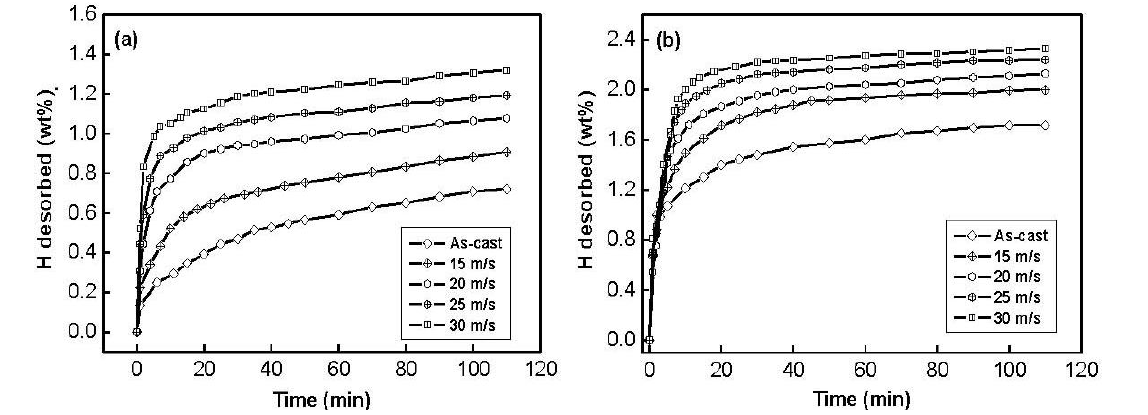
) of the alloys with the 20